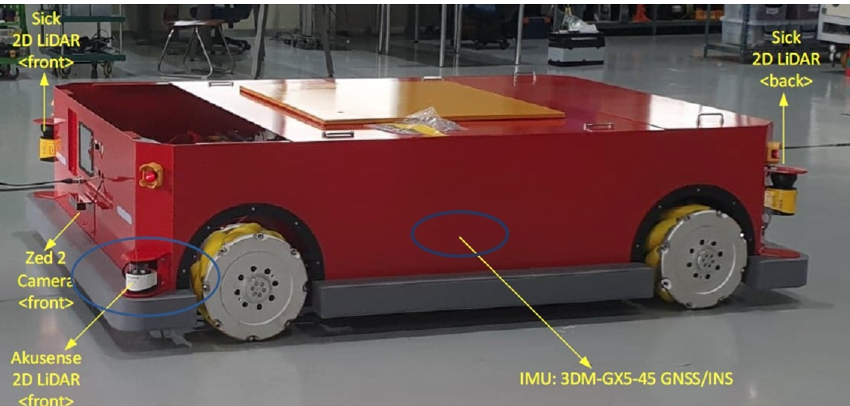
Figure 4. Robot setup used for data collection of the